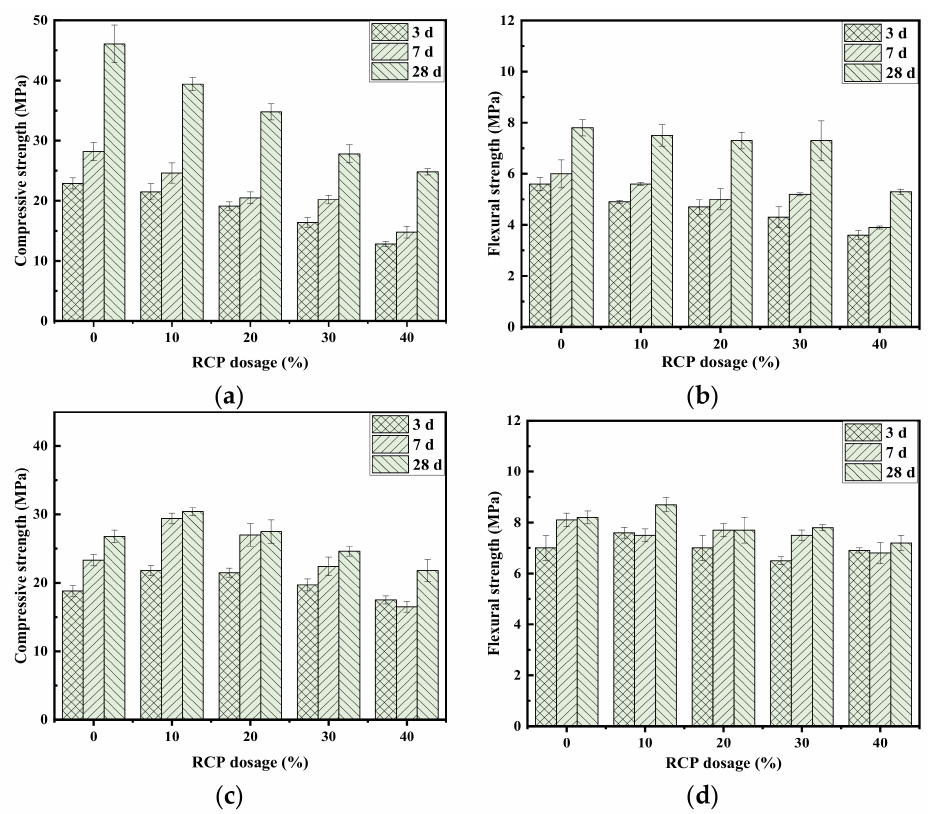
Figure 9. Influence of RCP content on mechanical properties. (( a ) Compressive strength for series A0–A4, ( b ) Flexural strength for series A0–A4, ( c ) Compressive strength for series B0–B4, ( d ) Flexural strength for series